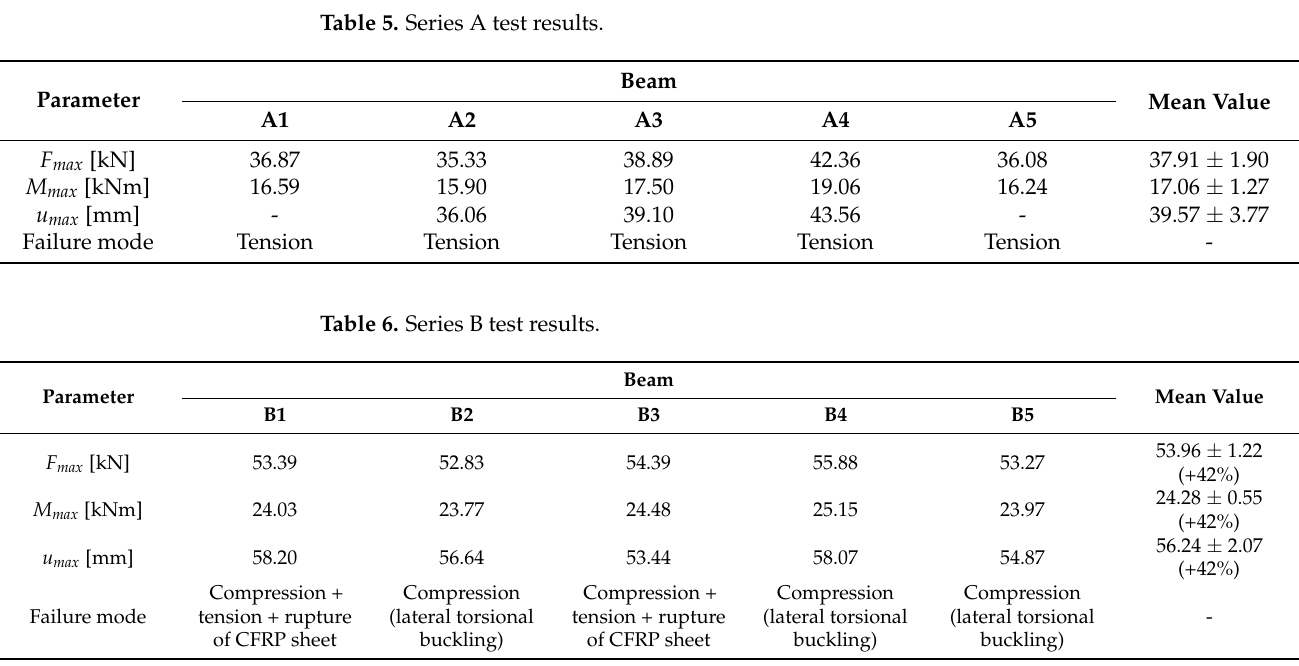
Figure 5. Load-deflection curves of D series beams.